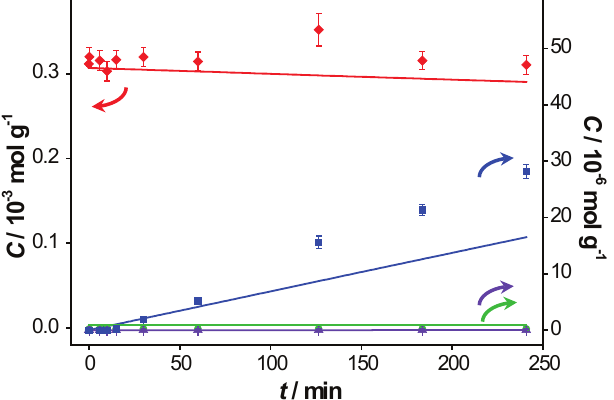
Figure 12. Catalyst performance of the water-washed spent catalyst in base-free conditions from Figure 2 in the presence of water. Concentration of ( ♦ ) benzyl alcohol, ( ■ ) benzaldehyde, ( ● ) benzoic acid and ( ▲ ) benzyl benzoate vs. reaction time for catalytic reaction spent AUROlite ™ in the presence of water. Reaction conditions: T = 80 °C, 0.8 g O, C = 3.0 × 10 − 4 mol · g − 1 , in 80 mL of toluene, 200 mL · min − 1 AUROlite ™ , ~1 g H 2 BnOH, t=0 air flow. Concentrations are expressed in moles per unit mass of liquid in the reactor (mol · g − 1 ). The symbols with error bars are the experimental results and the lines represent the kinetic